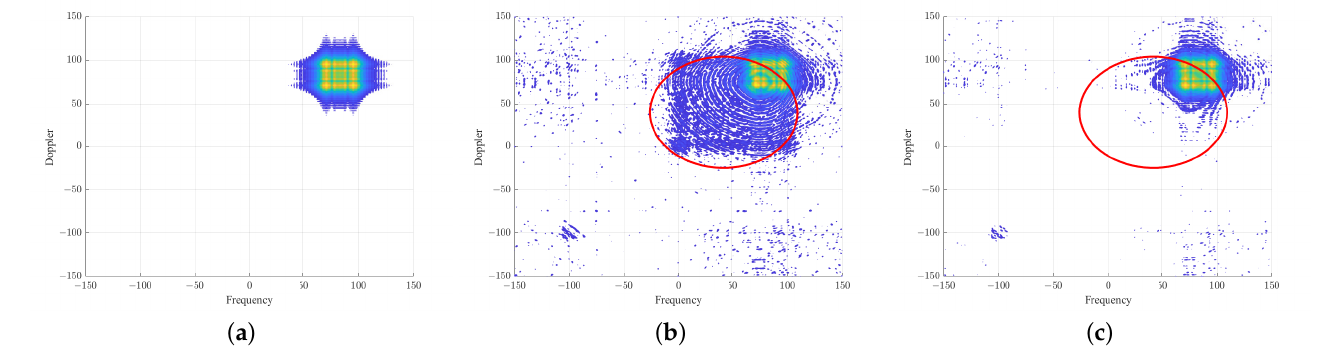
Figure 9. The three-dimensional spectrum of a wideband signal with the oversampling rate set to 3. ( a ) Results with high-precision quantization. ( b ) Results with one-bit quantization. ( c ) Results with the proposed two-bit quantization.